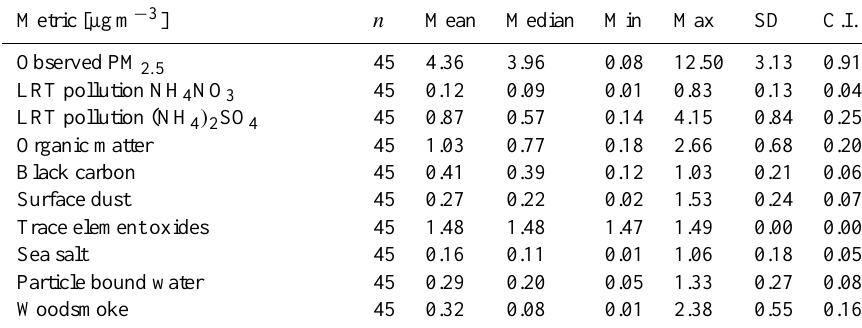
Figure 3. A comparison of the four receptor model PM 2 . 5 source apportionment time series in Halifax during BORTAS-B: (a) absolute prin- cipal component scores (APCS), (b) pragmatic mass closure (PMC), (c) chemical mass balance (CMB) and (d) positive matrix factorization (PMF). Table 4. Pragmatic mass closure PM 2 . 5 source apportionment descriptive